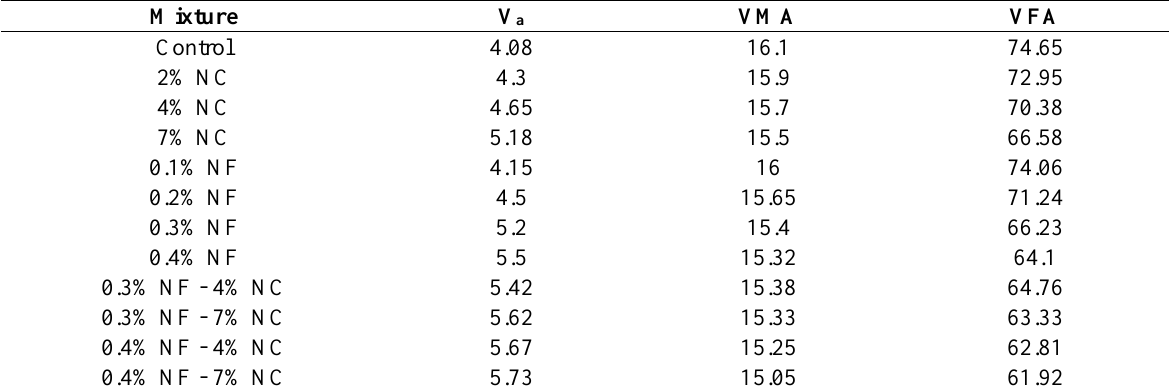
Table 6. Volumetric properties of the mixtures